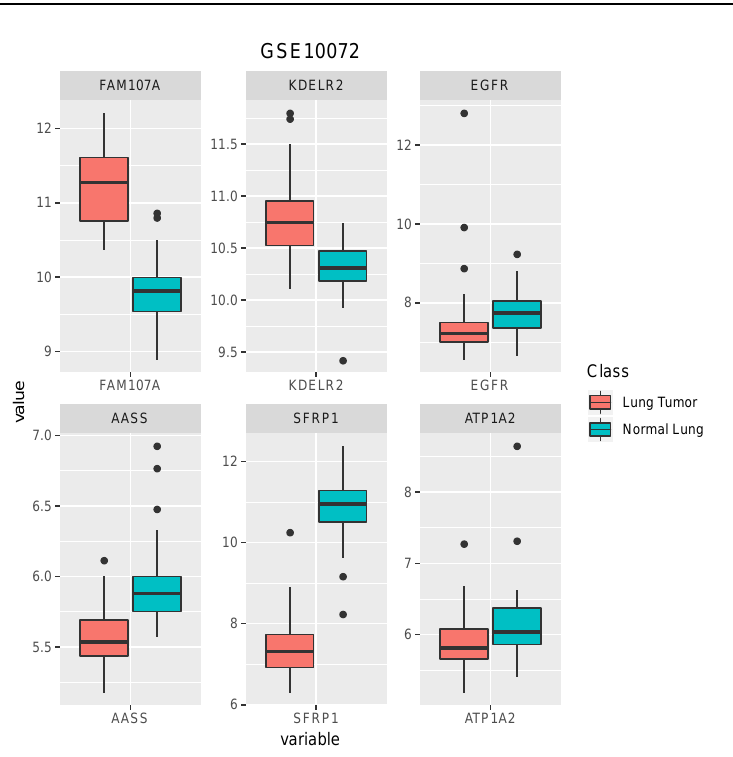
Figure 3. The box plots of selected genes by L 1/2 for dataset